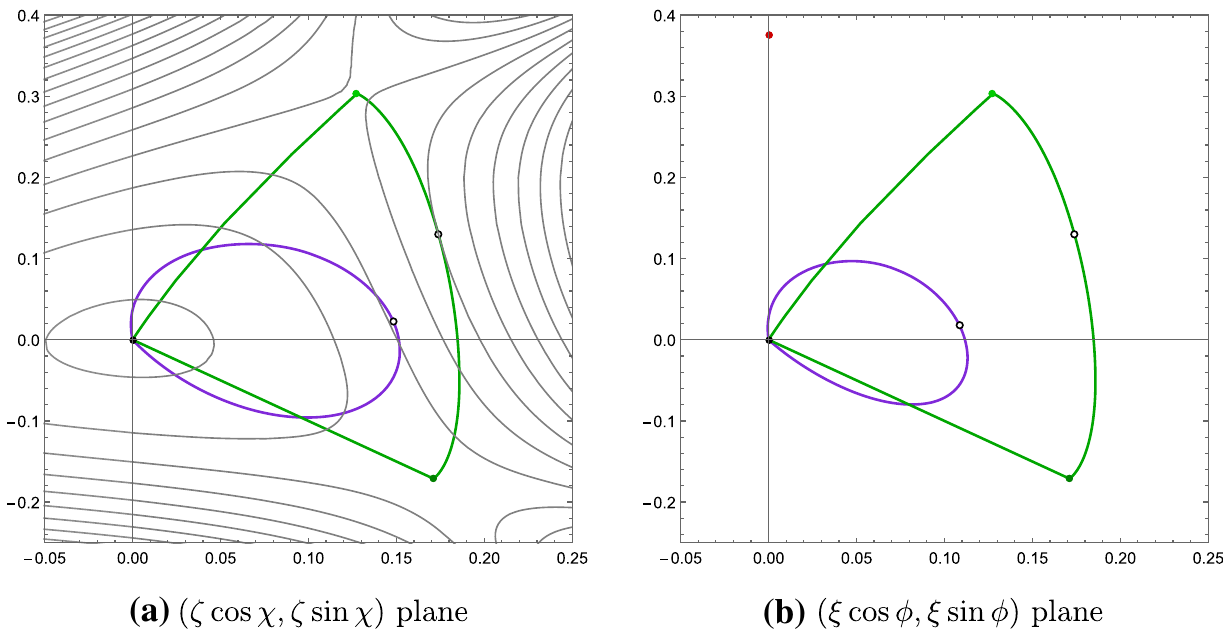
are shown by purple and green lines, 8